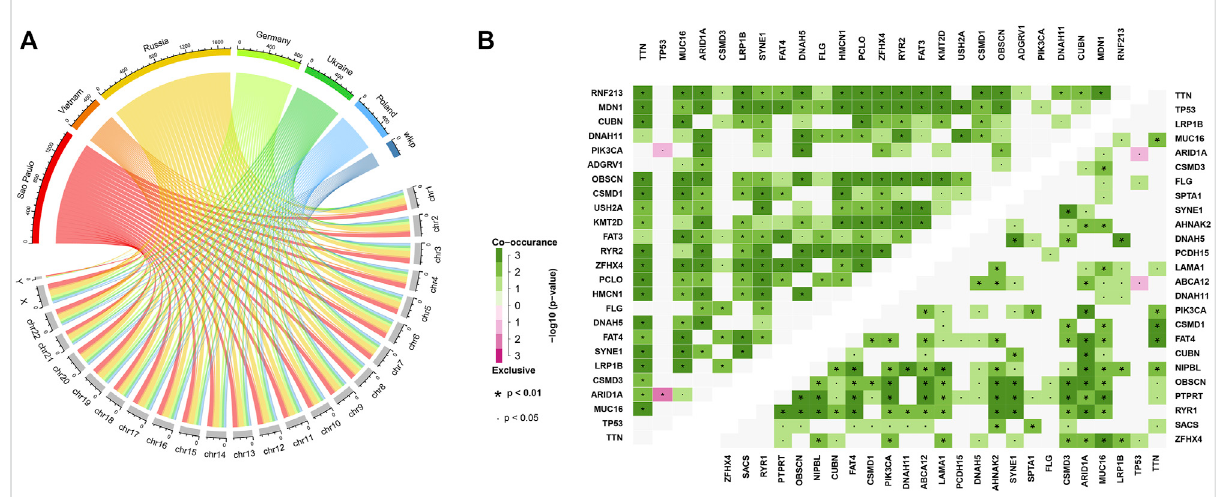
FIGURE 3 Mutational distribution, co-occurrence, and exclusive analysis. (A) Chromosomal mutational distribution of samples in various countries. (B) Co-occurrence and exclusive analysis of the top 25 mutational genes in high latitudes (upper left heatmap) and in low latitudes (bottom right heatmap). The signi fi cance was colored based on the adjacent color